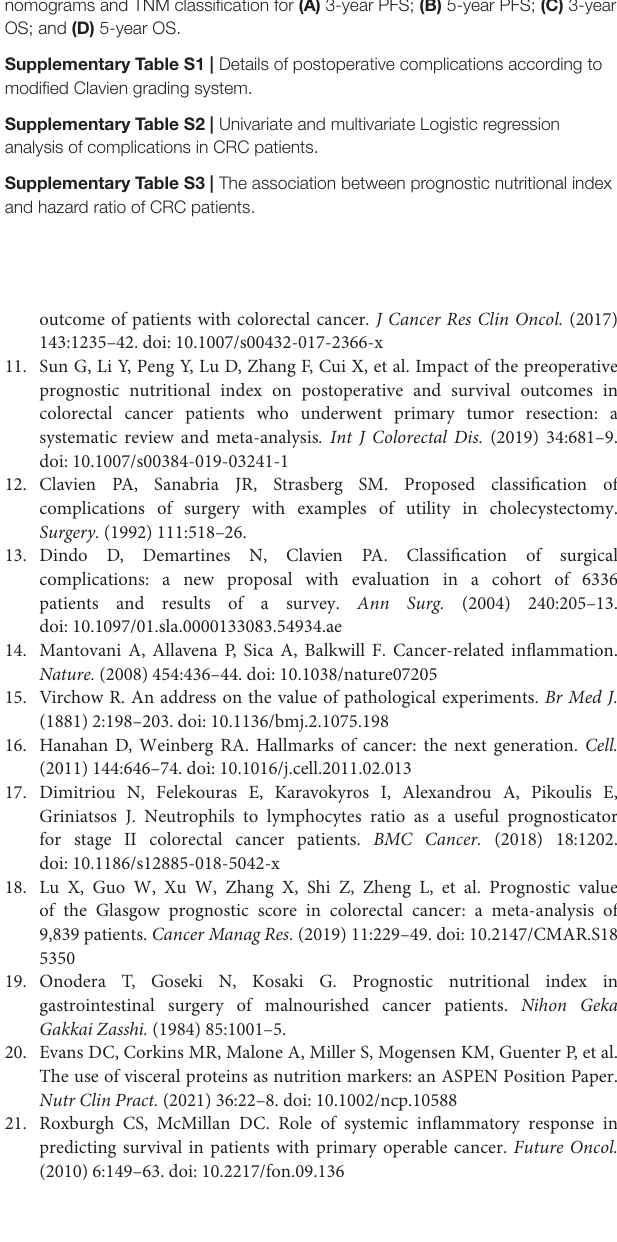
Supplementary Figure S4 | Subgroup survival analysis based on various clinicopathological features. (A) Subgroup PFS analysis; (B) Subgroup OS analysis. Supplementary Figure S5 | Comparison of the ability of PNI and other prognostic indexes in predicting prognosis of CRC patients using ROC curves. (A) PFS at 3-year point; (B) PFS at 5-year point; (C) OS at 3-year point; (D) OS at 5-year point. Supplementary Figure S6 | Calibration curve of novel complication nomograms. (A) 3-year PFS; (B) 5-year PFS; (C) 3-year OS; (D) 5-year OS. The X axis presents the predicted probability and the Y axis shows the actual probability. The calibration lines fit along with the 45 ◦ reference. Supplementary Figure S7 | Comparison of the ability of novel prognostic nomograms and TNM classification in predicting prognosis at 3-year and 5-year point. (A) 3-year PFS; (B) 5-year PFS; (C) 3-year OS; (D) 5-year OS. Supplementary Figure S8 | Decision curve analyses of novel prognostic nomograms and TNM classification for (A) 3-year PFS; (B) 5-year PFS; (C) 3-year OS; and (D) 5-year OS. Supplementary Table S1 | Details of postoperative complications according to modified Clavien grading system. Supplementary Table S2 | Univariate and multivariate Logistic regression analysis of complications in CRC patients. Supplementary Table S3 | The association between prognostic nutritional index and hazard ratio of CRC